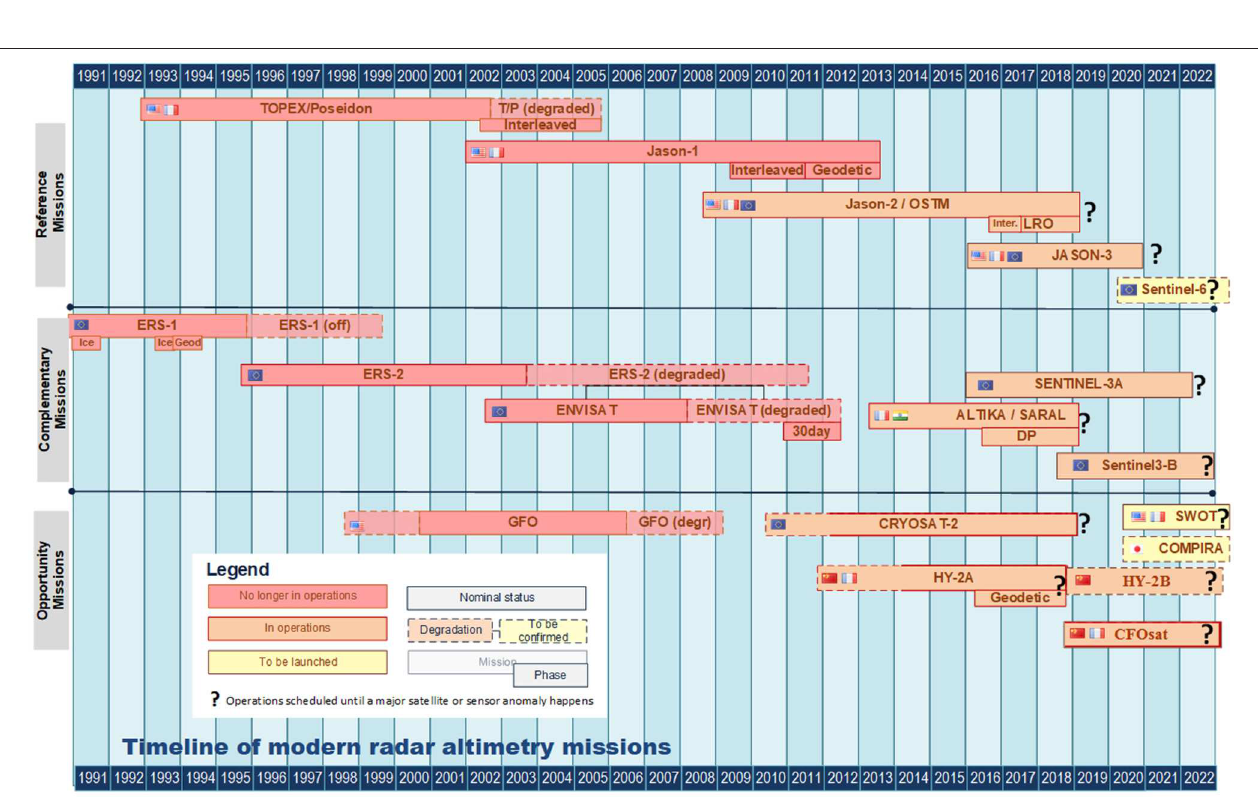
FIGURE 2 | Constellation of high precision altimeter satellites; Status in April